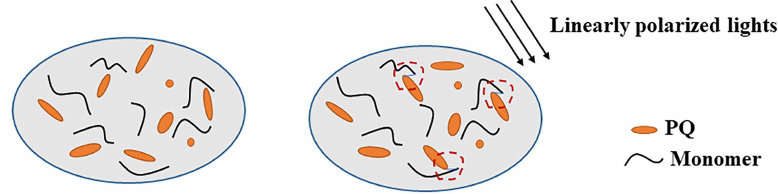
Figure 6. Photoreaction principle of phenanthrenequinone (PQ)/PMMA